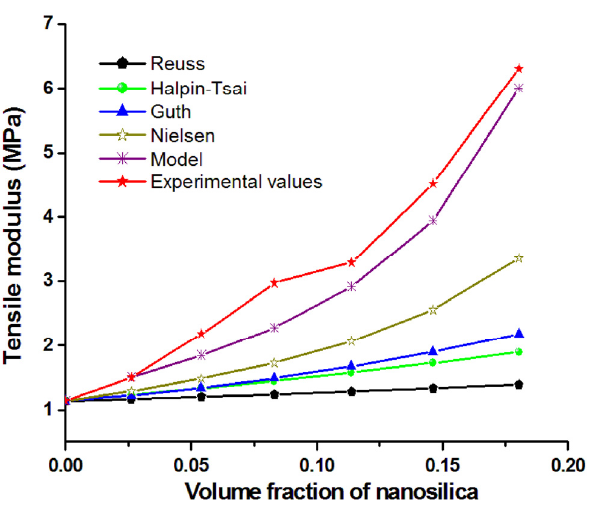
Figure 6. Experimental values of the tensile modulus and theoretical values determined using dif- ferent models (Reuss, Halpin–Tsai, Guth, Nielsen and Ji). different models (Reuss, Halpin–Tsai, Guth, Nielsen and